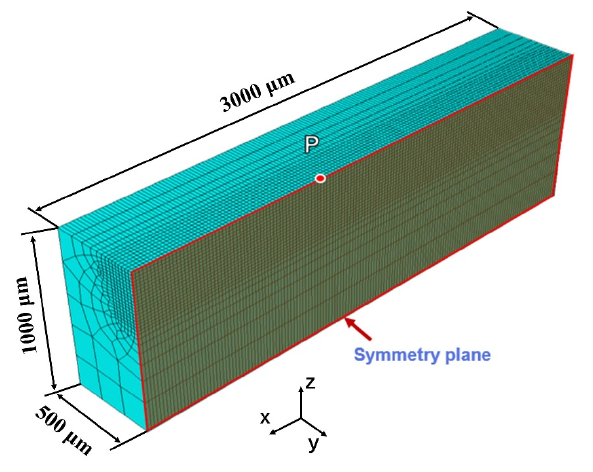
Figure 1. FEM model description.